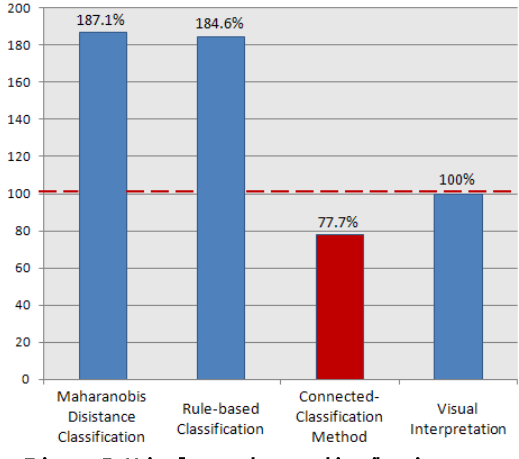
Figure 5. Vinyl greenhouse distribution area by classification